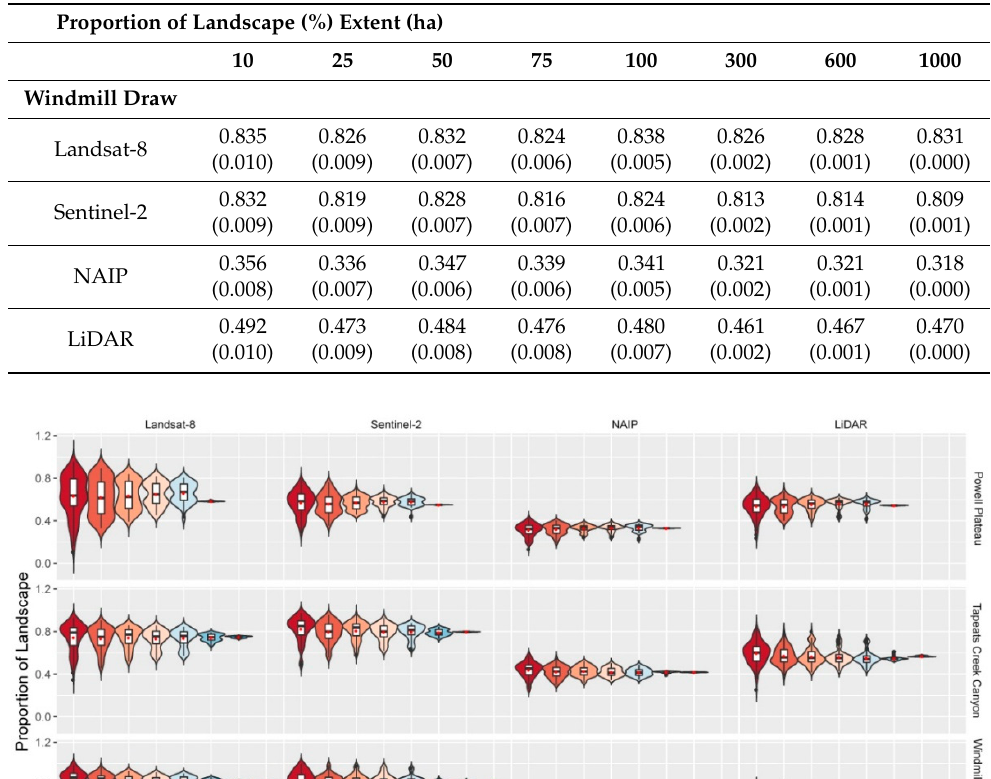
Table 3. Patch density (PD),the average number of patches of canopy cover on each landscape, delineated by each data product (Landsat-8 30 m, Sentinel-2 10 m, NAIP 1 m, LiDAR 1 m) and across multiple spatial extents. Mean values and standard error (SE) are shown.